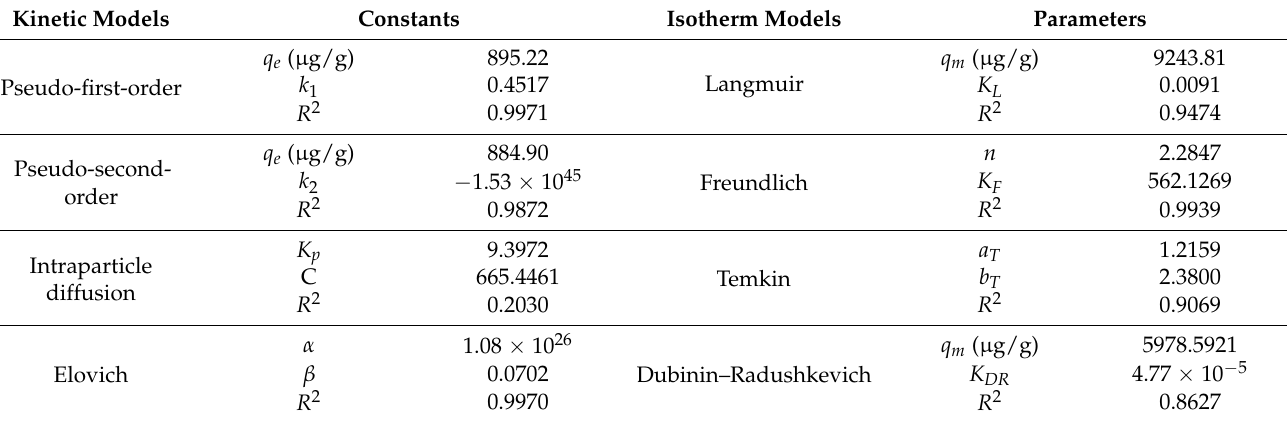
Table 1. Kinetic model and Isotherm model parameters for adsorption of Cd (II) ions by Fe 3 O 4 @PB. Kinetic